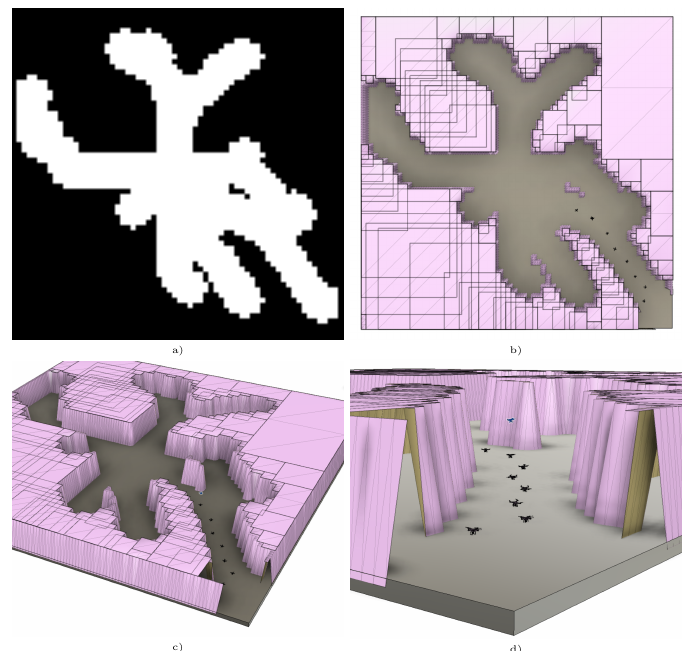
Figure 2. ( a ) Example of environment obtained by Algorithm 1, representing an area of 15 m × 15 m. ( b ) 3D visualization of this environment. Several bottom-right walls have been removed to highlight the access point to the environment. ( c , d ) Example of drone entry process and first steps of deployment